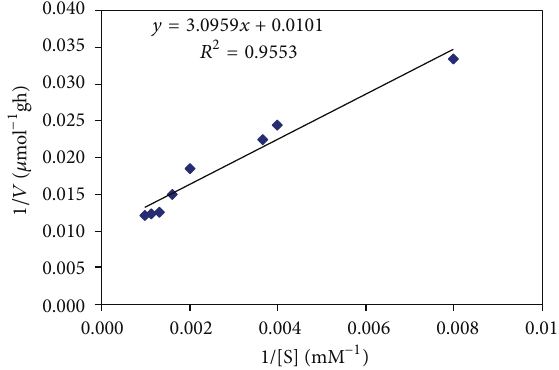
Figure 4: Lineweaver-Burk plots of immobilized R. oryzae 3562 lipase for benzyl acetate synthesis in solvent-free